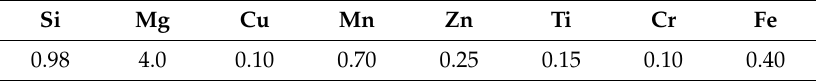
Table 1. Chemical composition (in wt %) of the AA5083 Al